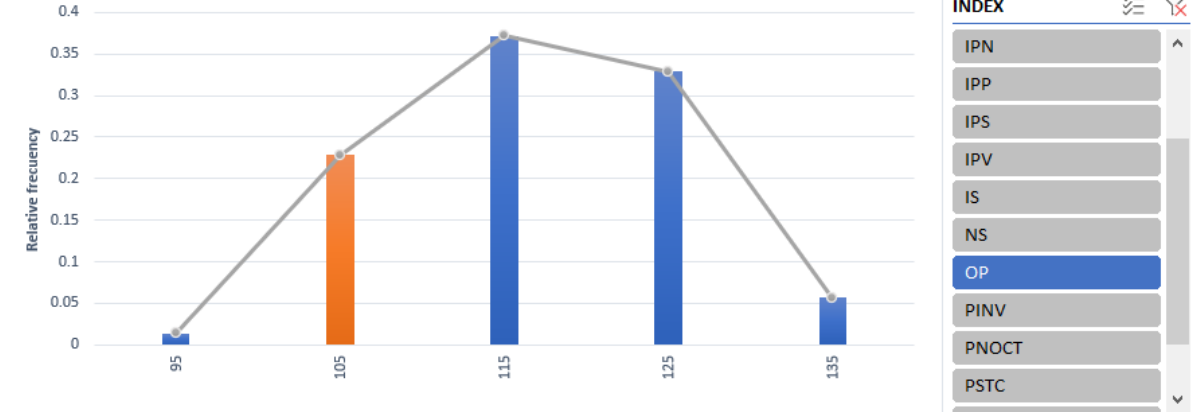
Figure 19. Example of Excel application output provided as additional information.